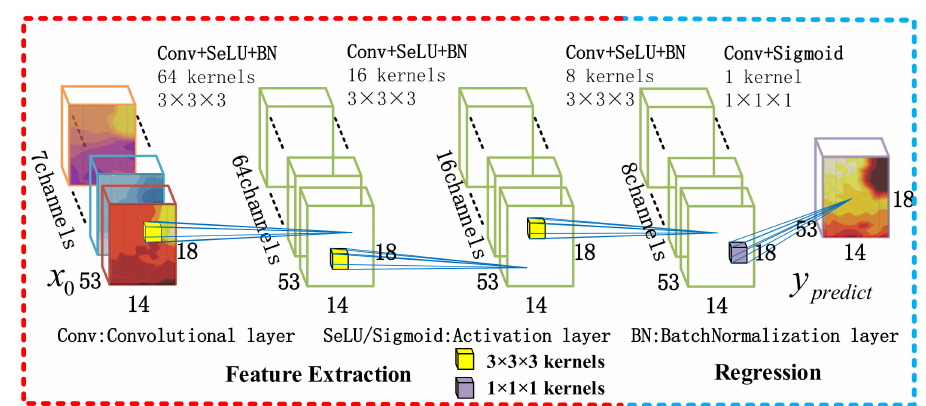
Figure 5. 3D Fully Convolutional Neural Network Model (MODL-PLAIN) structure. The seven-channel tensor on the left is the input of the model, which is the seven weather elements of the numerical forecast model. The single-channel tensor on the right is the output of the model, which is the forecast result of MODL-PLAIN. The three green tensors in the middle are the output feature tensors of the middle convolutional layer. The feature tensor has the same shape and di ff erent